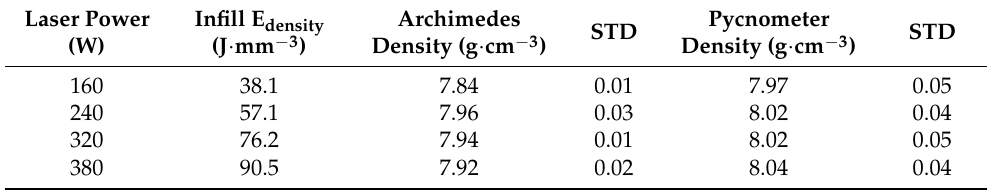
Table 2. Density of 316LSS produced by